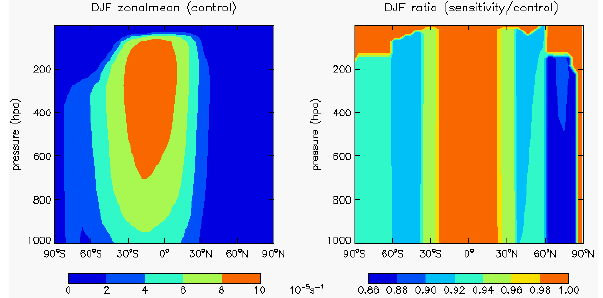
Fig. 1b. Same as Fig. 1a, but for June–August.